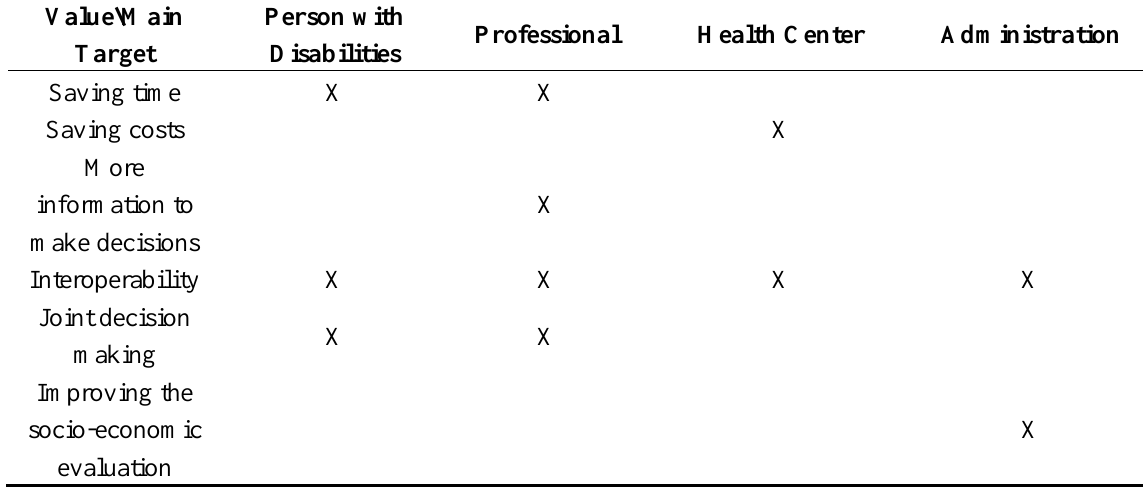
Table 4. Analysis of the potential value of the monitoring and prognosis